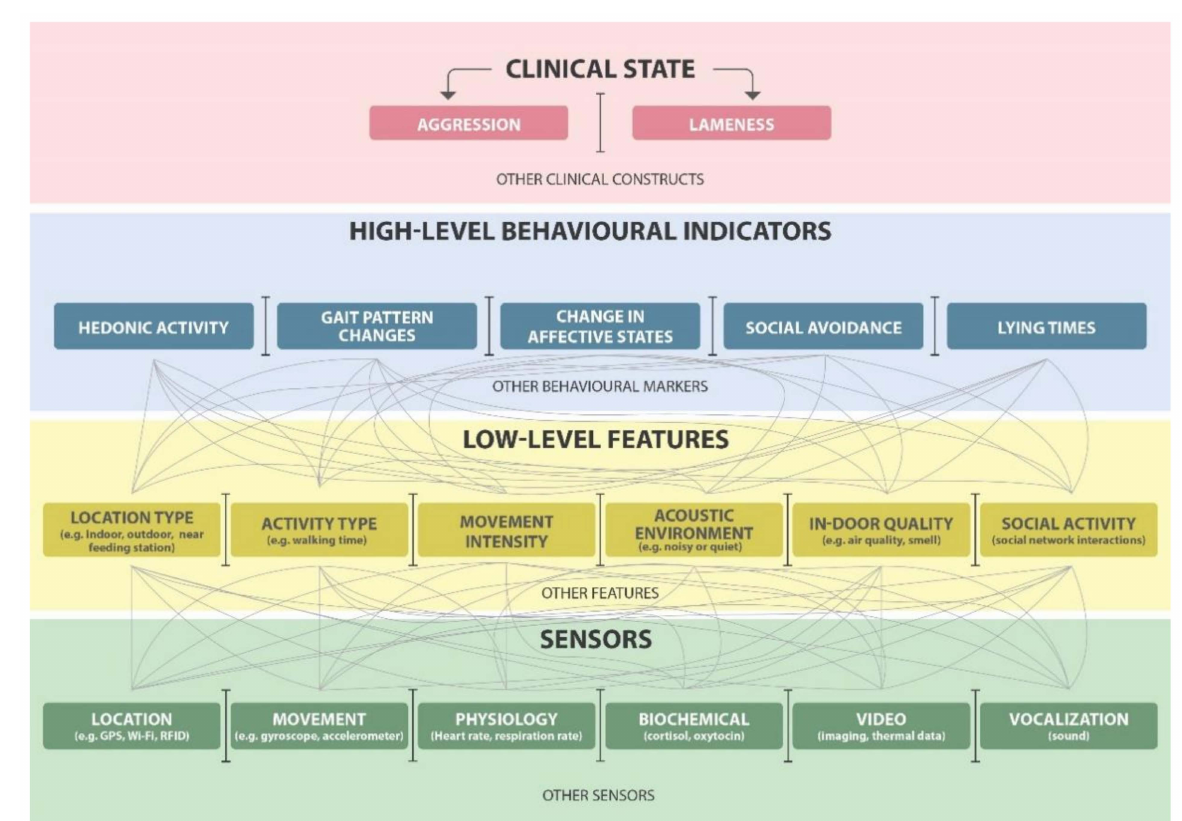
Figure 2. A typical hierarchical and layered sense-making framework for livestock digital phenotyping. Green boxes at the bottom represent inputs of data from sensor platforms; yellow boxes represent the features; blue boxes represent the behavioral biomarkers obtained from the sensors for